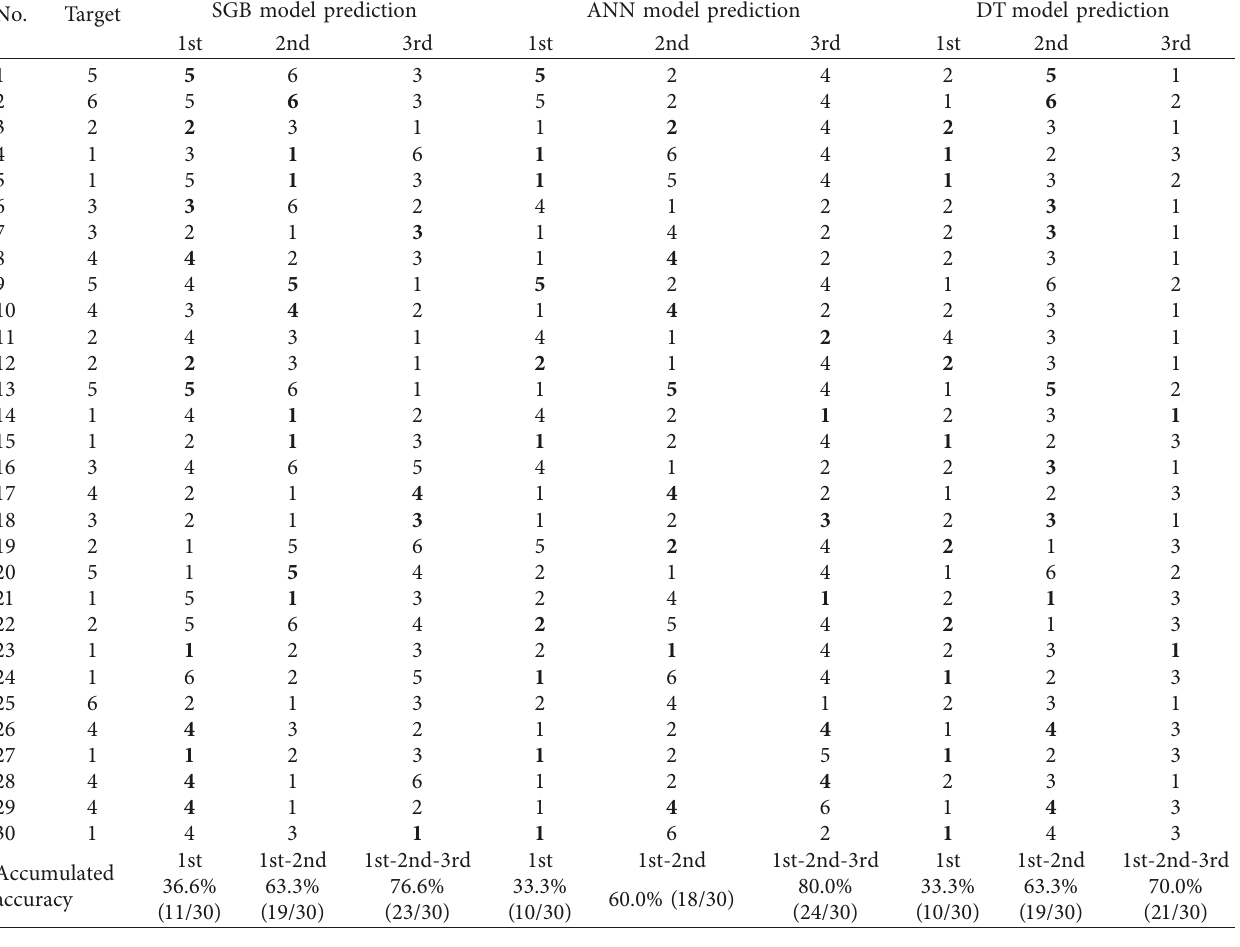
Tree graph for type of accident Num. of nonterminal nodes: 1, num. of terminal nodes: 2